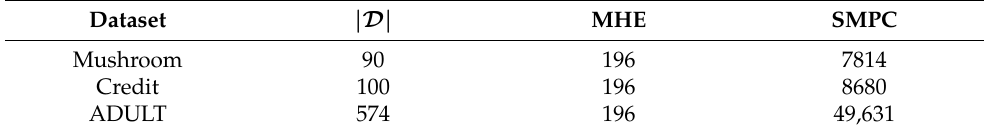
Table 8. Communication overhead (MB) of running the secure federated χ 2 -test on various datasets.